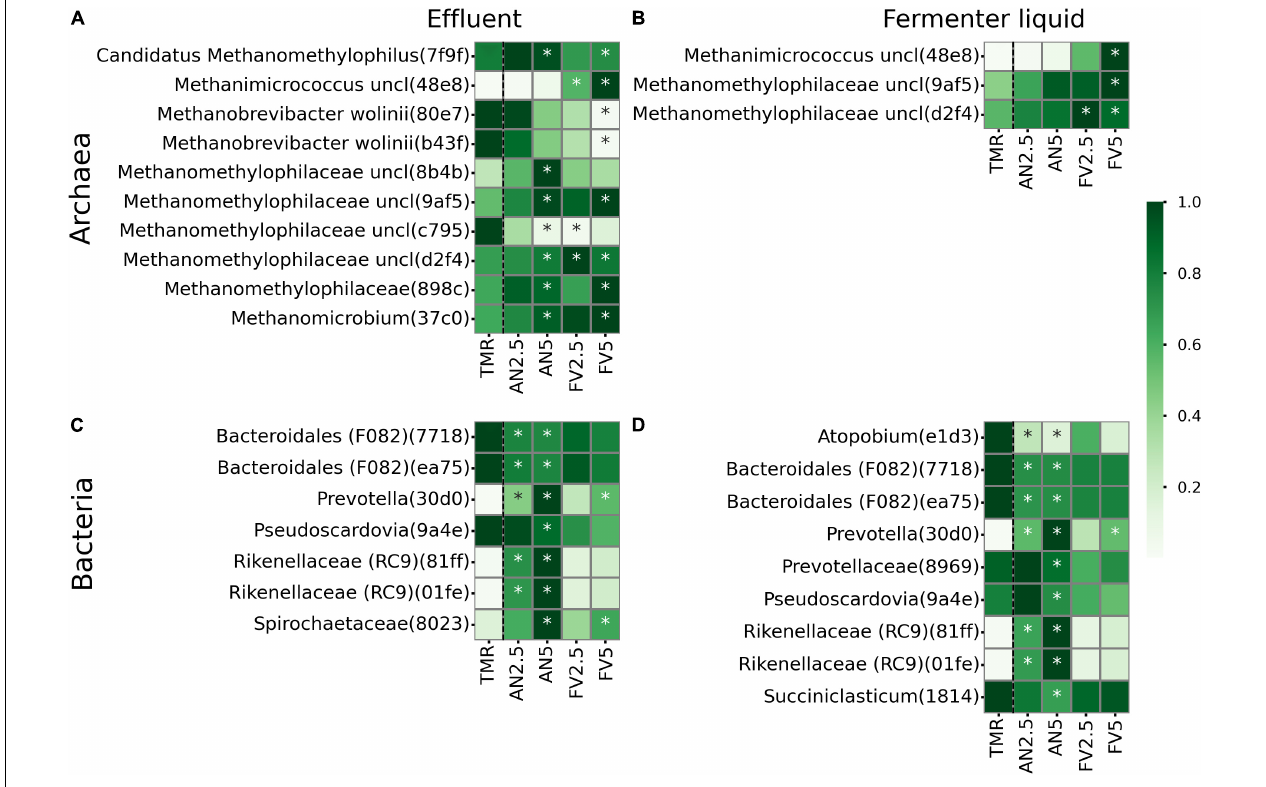
FIGURE 6 | Relative abundances of differentially abundant features according to ALDEx2. Relative abundances are normalized by rows. Archaeal (A,B) and bacterial (C,D) features from effluent (A,C) and fermenter liquid (B,D) sample types. All seaweed additives were compared with TMR. ALDEx2 significant abundances are marked by asterisks. All supplements were compared to TMR alone and separated by black dashed